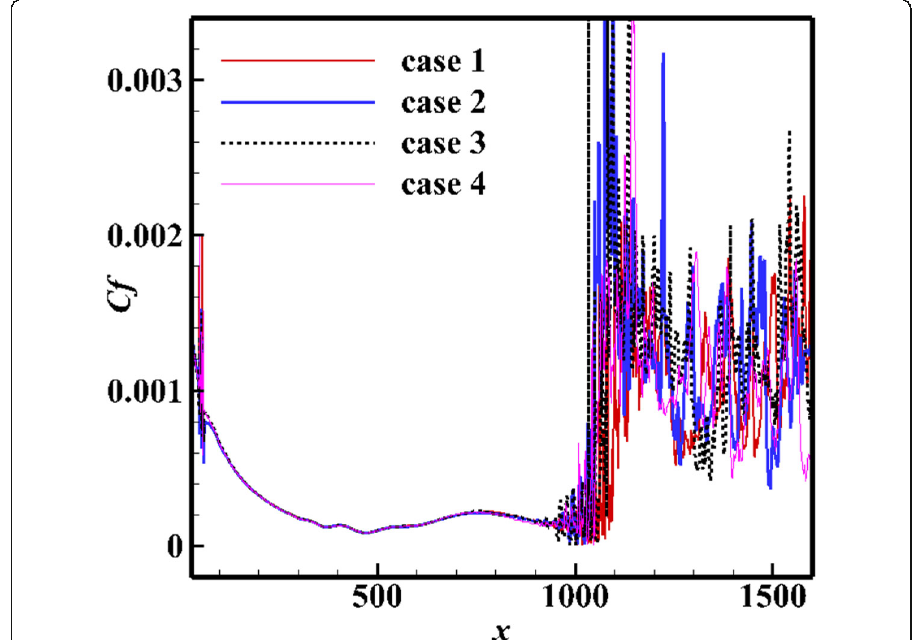
Fig. 5 The skin friction coefficient ( C f ) of the center line of the bottom surface of the lifting body. The grids of case 1 are 3000 × 1001 × 121, the grids of case 2 are 3000 × 2001 × 121, the grids of case 3 are 4350 × 2001 × 121 and the grids of case 4 are 4350 × 2001 ×